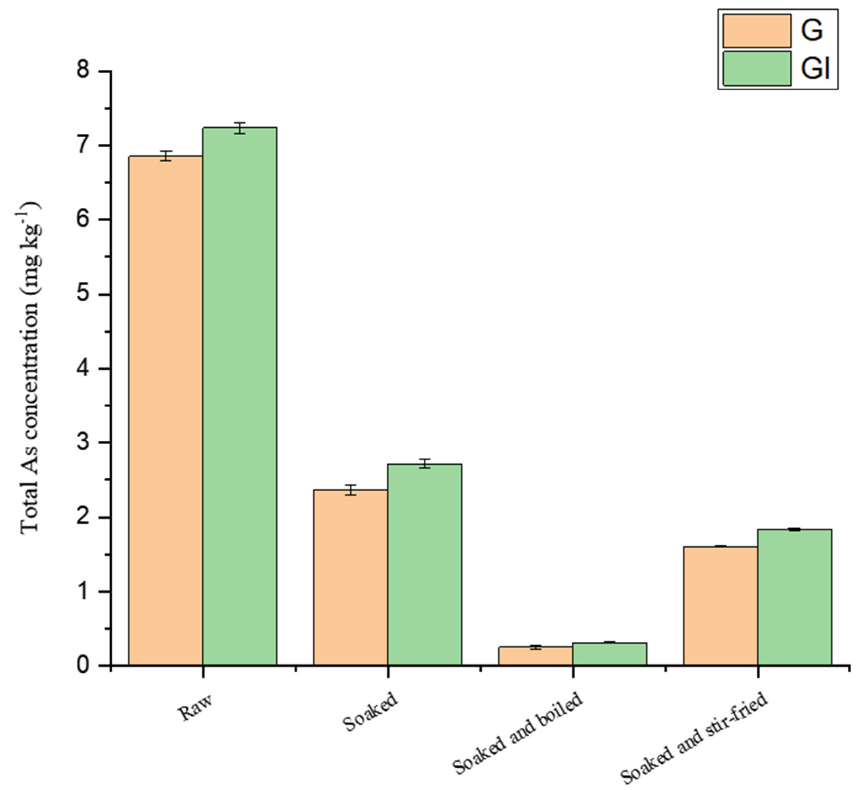
Figure 5. As content in G and GI fractions of Agaricus blazei Murill after different treatments.